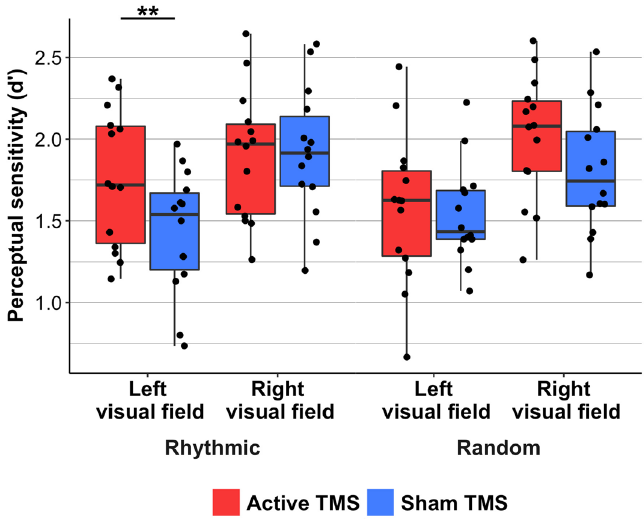
Figure 6. Modulation of perceptual sensitivity (d ′ ) for left and right hemifield visual targets presented across TMS stimulation patterns delivered to the right FEF. Boxplots are presented for the rhythmic (left) and random (right) stimulation conditions contrasting active (in red) vs sham (in blue) patterns for targets presented in the left (contralateral to right FEF stimulation) and the right (ipsilateral to right FEF stimulation) visual hemifield. Boxes are drawn from the 25th to the 75th percentile and the horizontal line indicates the median. Whiskers are drawn between the minimum and maximum data points. Black dots represent individual d ′ measures for each individual participant (for details on statistical approaches refer to the Results section). ** : p < 0.01 in post- hoc t-tests between active vs sham conditions. Notice that perceptual sensitivity was increased only for targets contralateral to the stimulation site (left) in active compared to sham rhythmic TMS patterns. Decision criterion (not presented in the current manuscript) was not significantly modulated by differnt patterns of stimulation. Note also that the current figure, showing the behavioural impact on conscious visual detection across different TMS conditions has been compiled with a dataset published previously 30 in different graphic